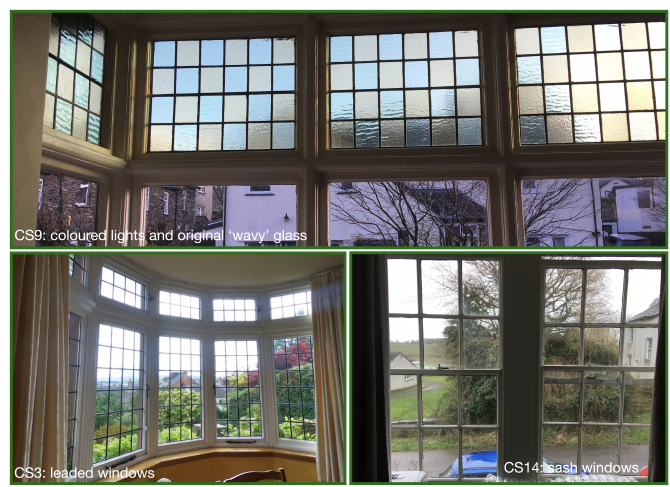
Figure 1. Original